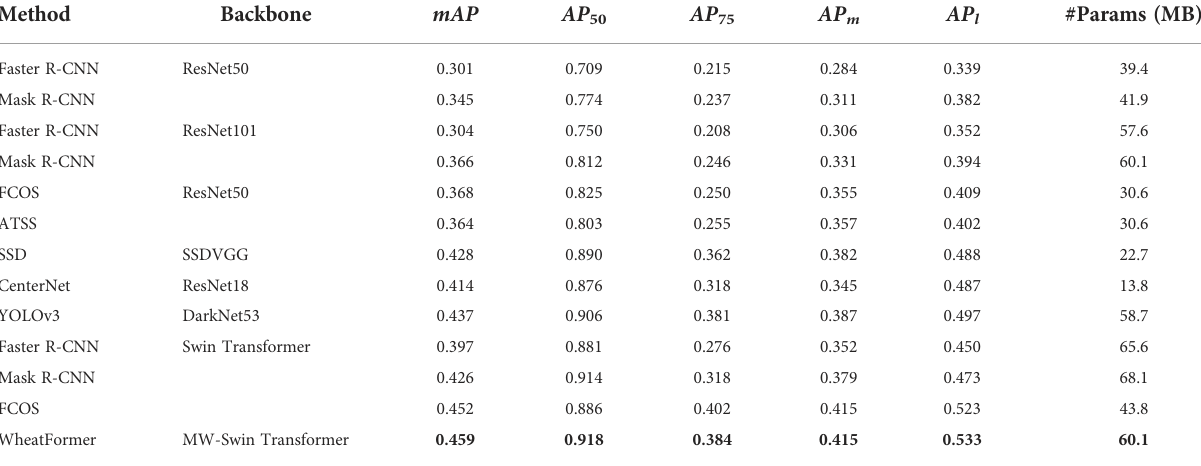
TABLE 3 Detection results on